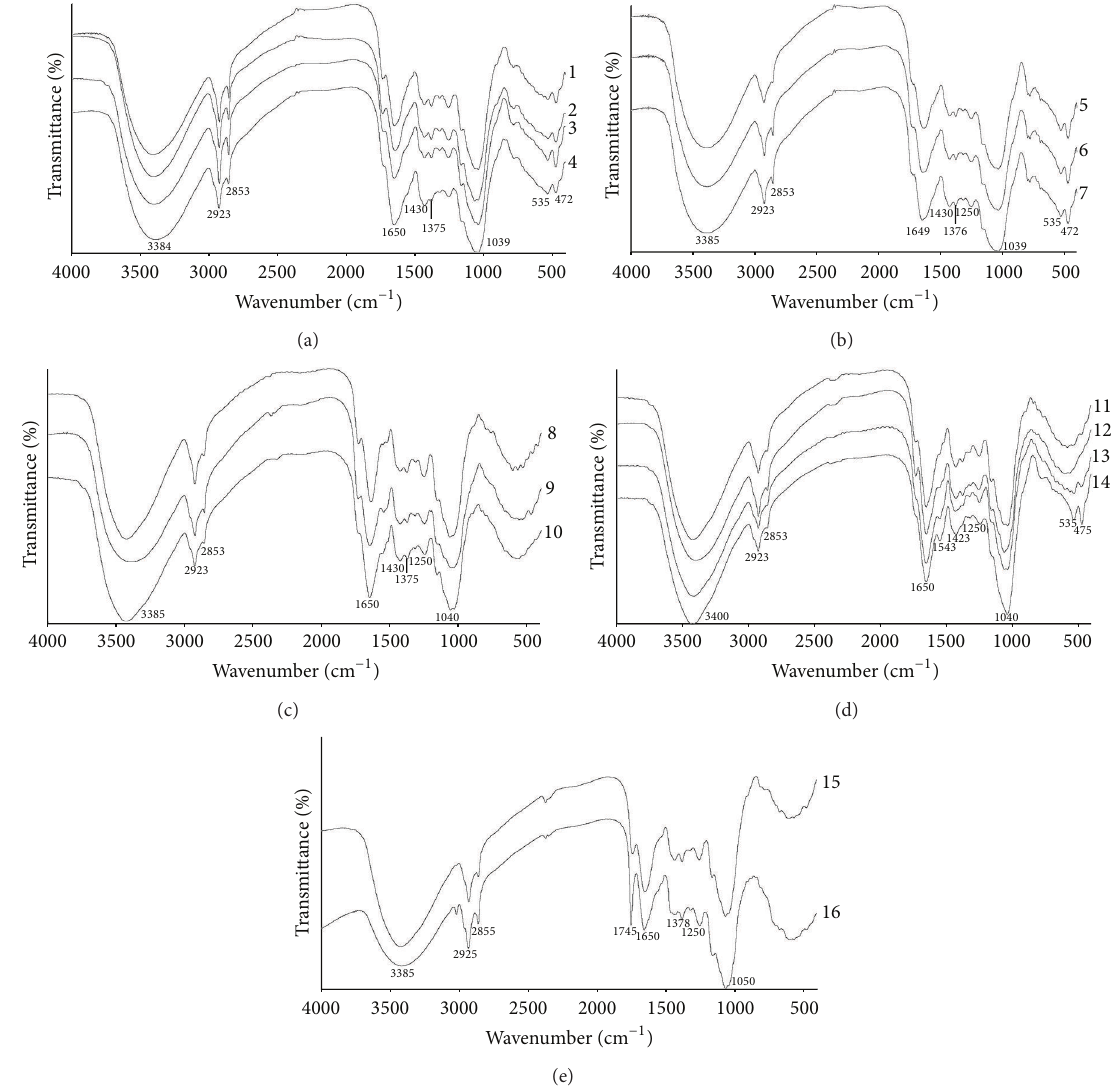
Figure 1: FTIR spectra obtained in the range of 4000 cm −1 to 400 cm −1 for the four species of family Mielichhoferiaceae (a), three species of family Bryaceae (b), and nine species of family Mniaceae (c), (d), (e); the characteristic peaks are indicated at the bottom.